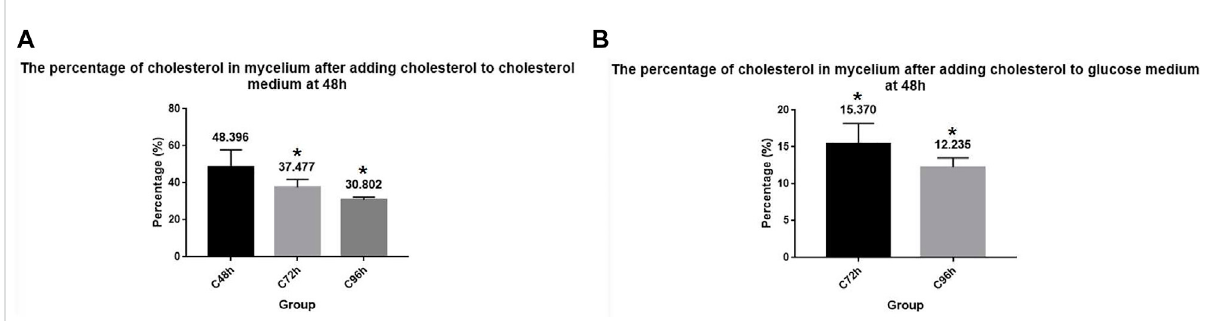
FIGURE 2 A. oryzae can absorb and utilize cholesterol instantaneously. (A) After fermentation of cholesterol medium by A. oryzae for 48 h, the same amount of cholesterol was added to the medium again, and the percentage of cholesterol in mycelium dry weight at different time points was estimated. (B) Afterfermentationofglucosemedium by A.oryzae for48 h,thesameamountofcholesterol wasaddedtothemedium again,andthe percentage of cholesterol in mycelium dry weight at different time points was determined. Three independent experiments were performed. The asterisk denotes statistically signi fi cant differences between the (A) and (B) at 72 h or 96 h based on Student ’ s t -tests (* p < 0.05).